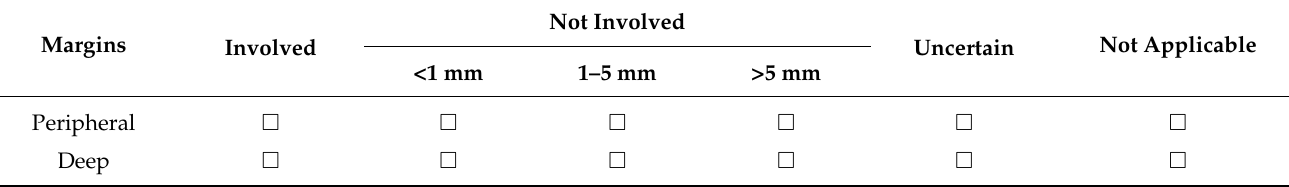
Table 2. Template for reporting pathological margins as proposed by the Royal College of